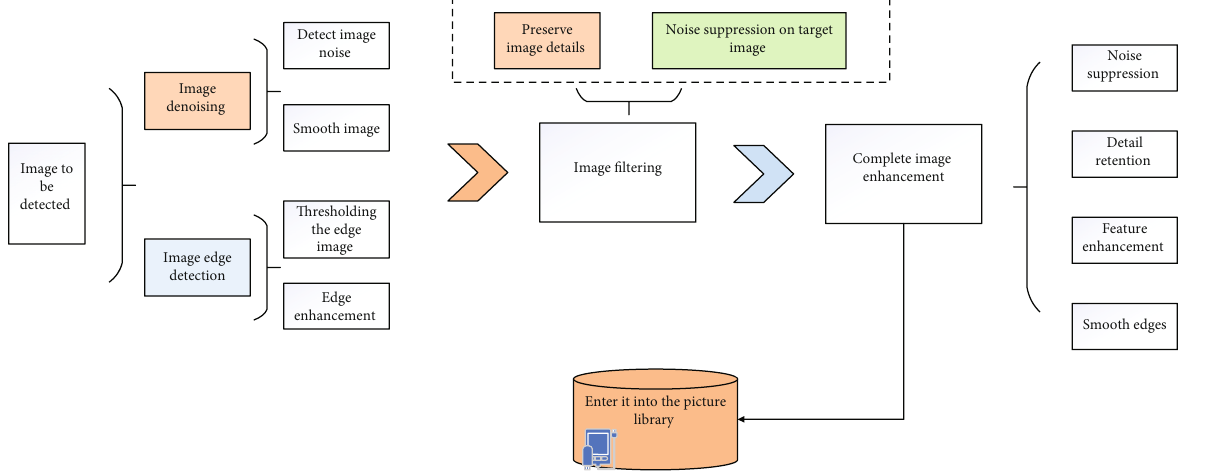
Figure 4: Image edge detection